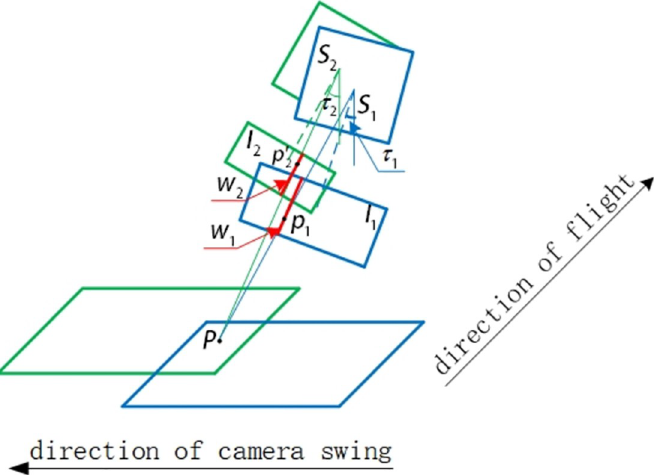
Fig 5. Schematic diagram of epipolar constraint of swing-sweep type aerial